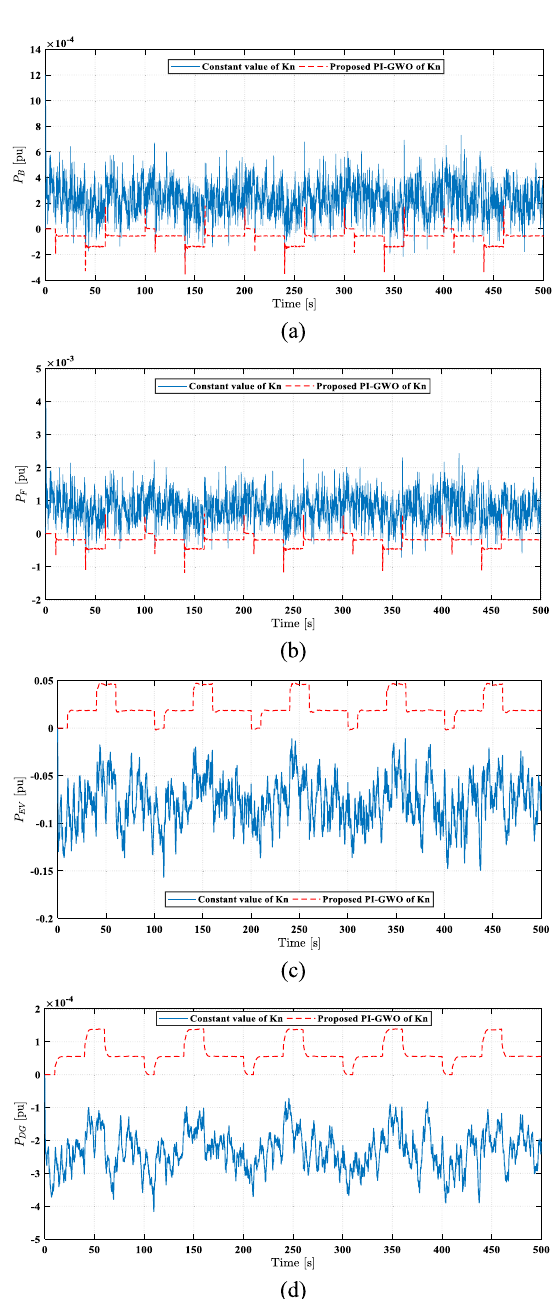
Fig. 17 The performance of HGS sources for Case 3: a battery power b flywheel power c EV power d DG